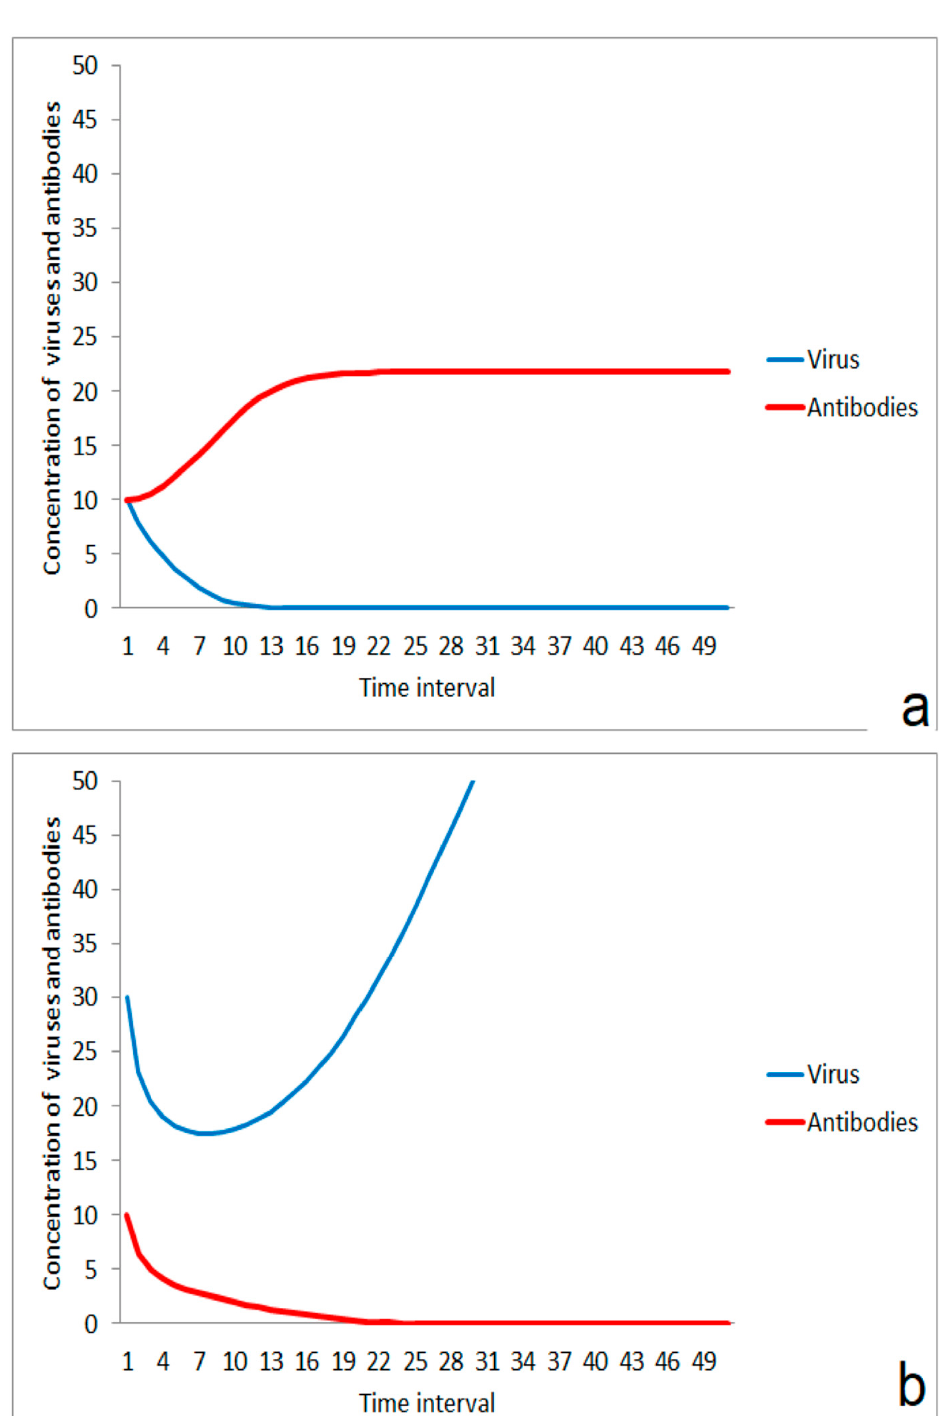
Figure 1. Competition between immune system and virus after impact: ( a ) suppression of infection after moderate virus impact, ( b ) outbreak of disease after a stronger impact by viruses.